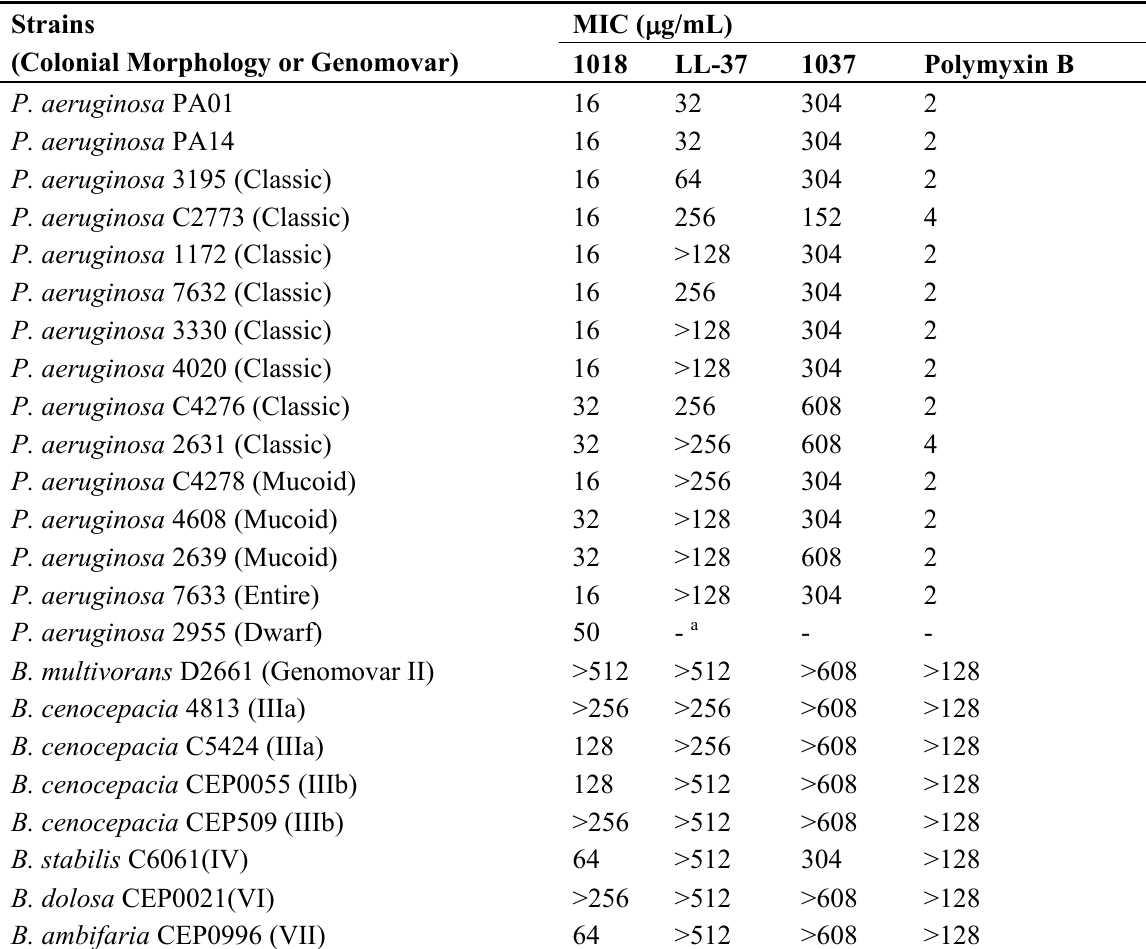
Table 1. Peptide 1018 demonstrated weak activity vs. planktonically-grown P. aeruginosa cystic fibrosis strains and no activity vs. B. cepacia complex cystic fibrosis isolates. All minimum inhibitory concentration (MIC) assays were performed at least three times. For comparison we included the previously studied P. aeruginosa (non-cystic fibrosis) wild type strains PAO1 and PA14 and B. cenocepacia 4813 [22], as well as showing results for two previously described anti-biofilm peptides (LL-37 [18] and 1037 [21]) and the